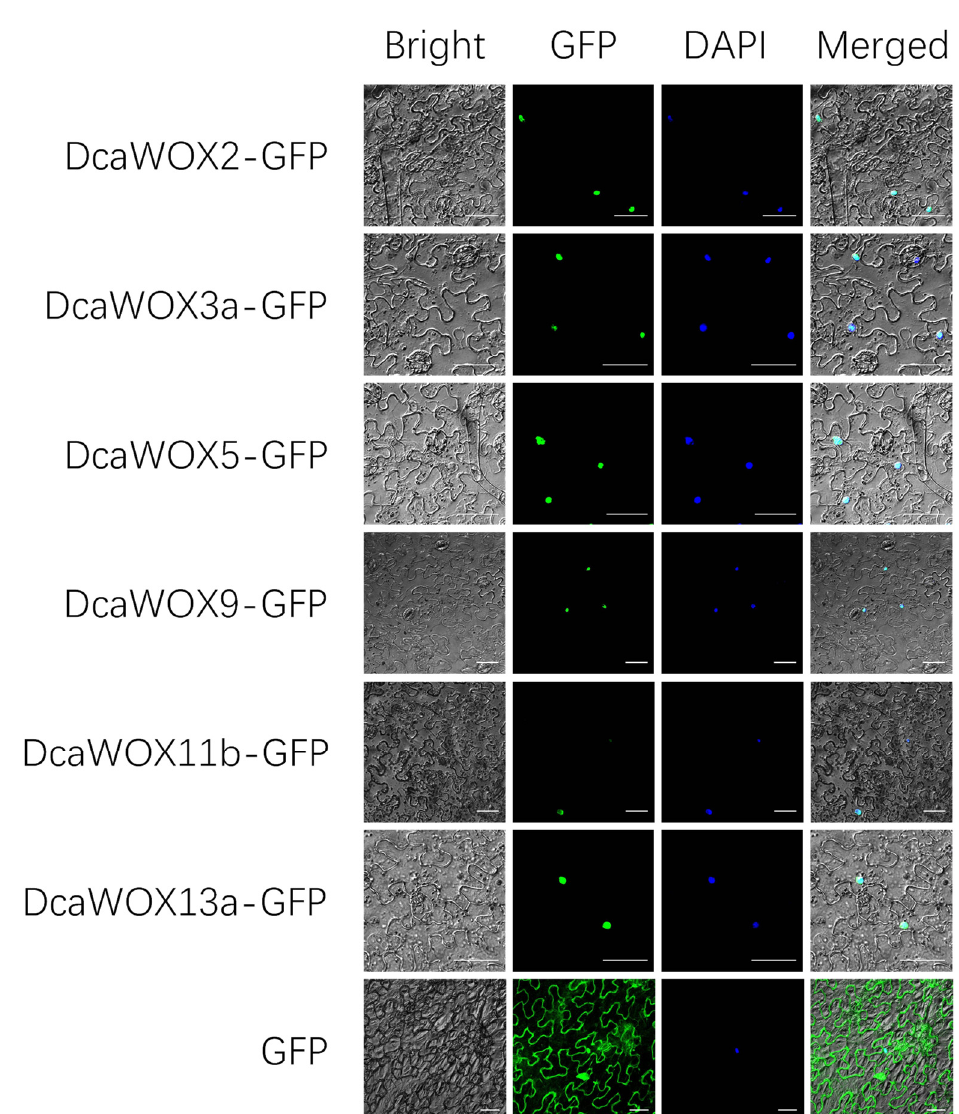
Figure 3. Subcellular localization of DcaWOX-GFP in Nicotiana benthamiana leaves. DcaWOX2-GFP, DcaWOX3a-GFP, DcaWOX5-GFP, DcaWOX9-GFP, DcaWOX11b, and DcaWOX13a were localized in the nucleus. Bar = 50 µ